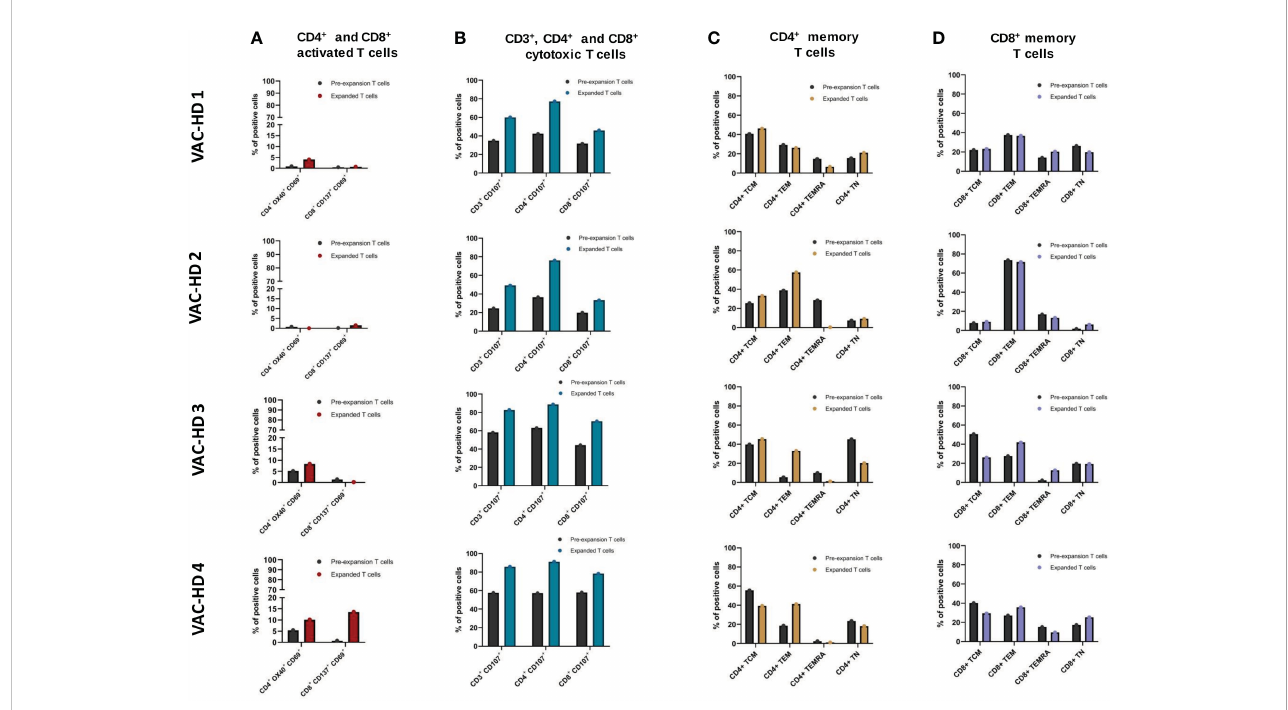
FIGURE 5 Phenotyping of the spike-speci fi c expanded T cells. (A) Frequency of CD4 + OX40 + CD69 + and CD8 + CD137 + CD69 + activated T cells within pre- expansion and expanded T cells following S1 stimulation in four BNT162b2 vaccinated participants. (B) Frequency of CD3 + CD107 + , CD4 + CD107 + , and CD8 + CD107 + cytotoxic T cells within pre-expansion and expanded T cells following S1 stimulation in four BNT162b2 vaccinated participants. (C) Frequency of CD4 + naïve (CCR7 + CD45RA + ), central memory (CCR7 + CD45RA − ), effector memory (CCR7 − CD45RA − ), and terminally differentiated memory (CCR7 − CD45RA + ) within pre-expansion and expanded T cells following S1 stimulation in four BNT162b2 vaccinated participants. (D) Frequency of CD8 + naïve (CCR7 + CD45RA + ), central memory (CCR7 + CD45RA − ), effector memory (CCR7 − CD45RA − ), and terminally differentiated memory (CCR7 − CD45RA + ) within pre-expansion and expanded T cells following S1 stimulation in four BNT162b2 vaccinated